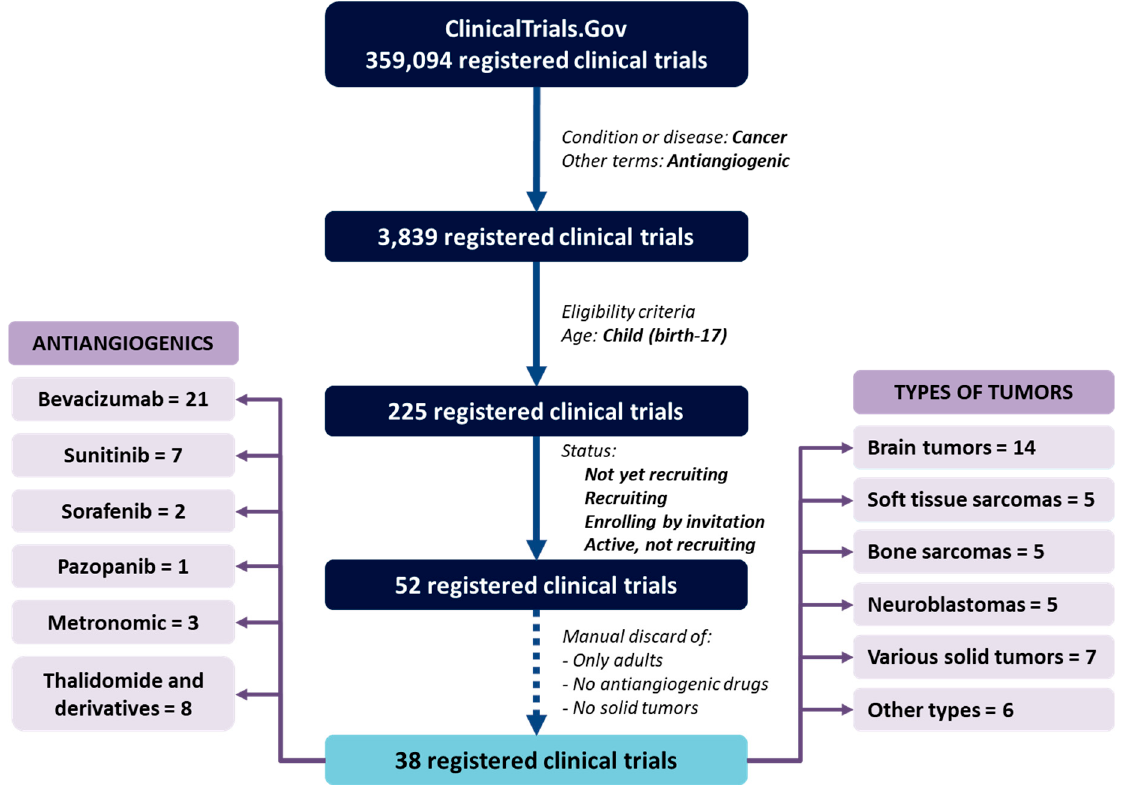
Figure 2. Active clinical trials that use antiangiogenic drugs in childhood cancer. The ClinicalTrial.gov database has 359,094 registered clinical trials at the time of this submission. If these trials are filtered by condition or disease (cancer) and other terms (antiangiogenic), the number is reduced to 3839. If only trials involving children (child: birth–17 years) and those that are active are selected, there are 225 clinical trials. After manually eliminating trials that include only adults, that are not solid tumors, and that do not use antiangiogenic treatments, there are 38 trials. Most of these study brain tumors, but there are also trials that include soft-tissue sarcomas, bone sarcomas, neuroblastomas, or others. Seven of the 38 trials allow the inclusion of patients with different types of cancer. In relation with antiangiogenics used, most trials use bevacizumab combined with other treatments, but there are also others directed against alternative proangiogenic pathways such as sunitinib, sorafenib, and pazopanib. Metronomic therapy, thalidomide, and its derivatives are also studied in the current clinical trials.